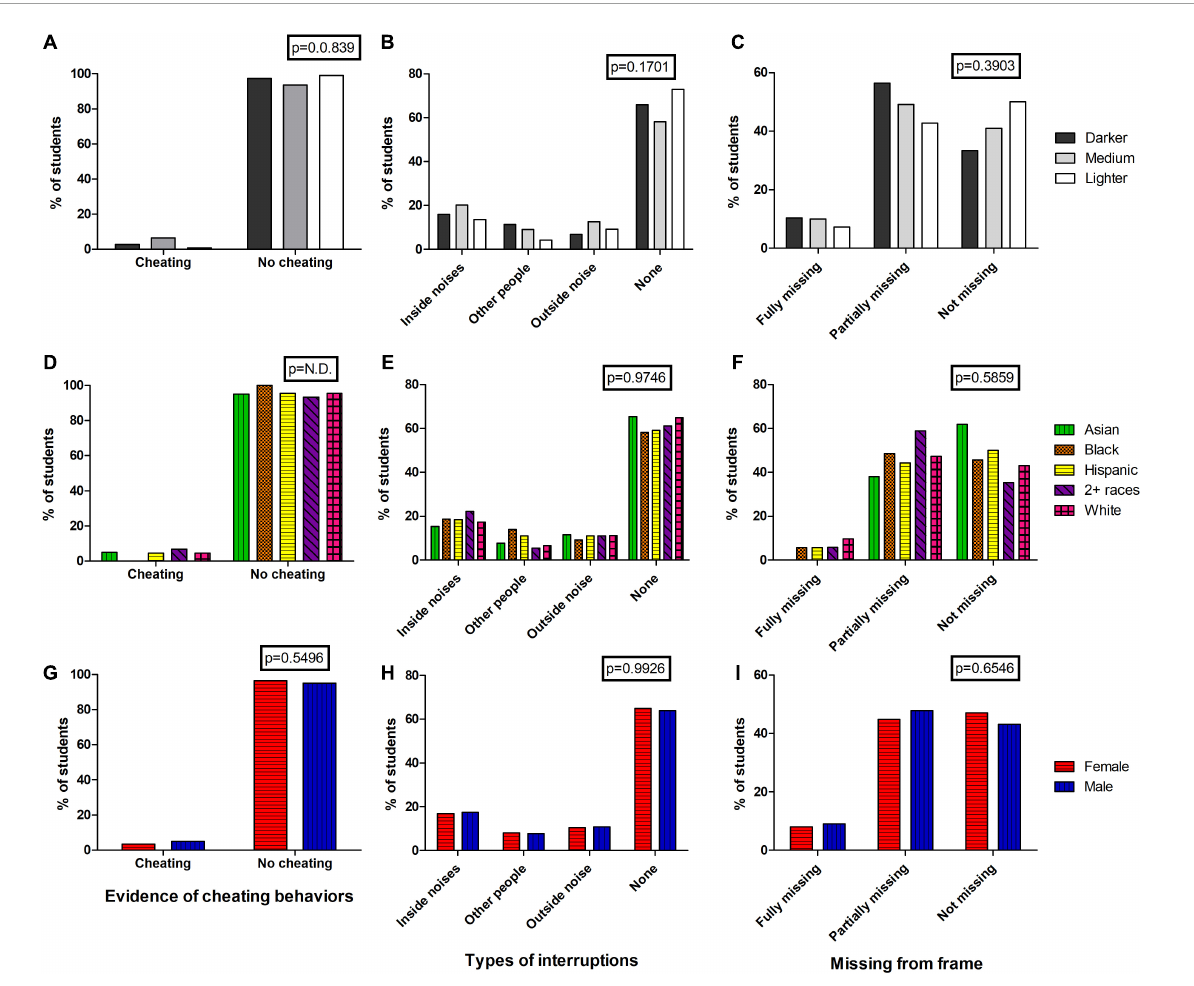
FIGURE6 Analysis of student videos for student behaviors. Videos of students were coded for potential cheating behaviors (A,D,G) , whether interruptions of the videos from inside/outside noises or other people in the same room were observed (B,E,H) , and whether students were either fully missing from the frame (e.g., walked away), partially missing from the frame (e.g., covered part of their face, leaned into the camera so that part of the face was missing) at any point in the video (C,F,I) . Percentages are shown in each bar and are color-coded for easy comparisons. Chi-squared values from raw data is shown in boxes at the top of each graph. N.D. = not determined due to 0 values in the dataset which did not comply with Chi-squared